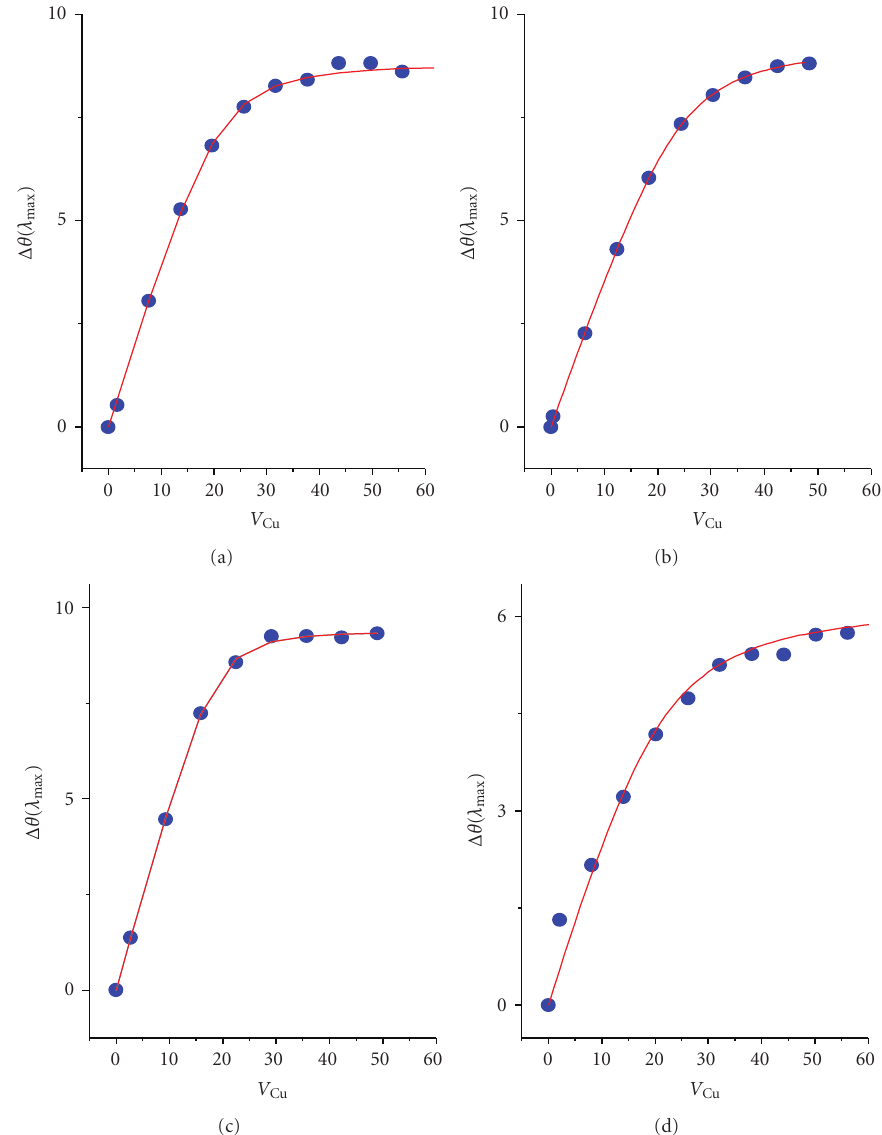
Figure 2: Titration curves (experimental points, , and fits to the K app formula, ) for Cu(II) binding at MBS in four solutions studied: (a) NaCl; (b) Hepes; (c) sodium phosphate; (d) Tris.